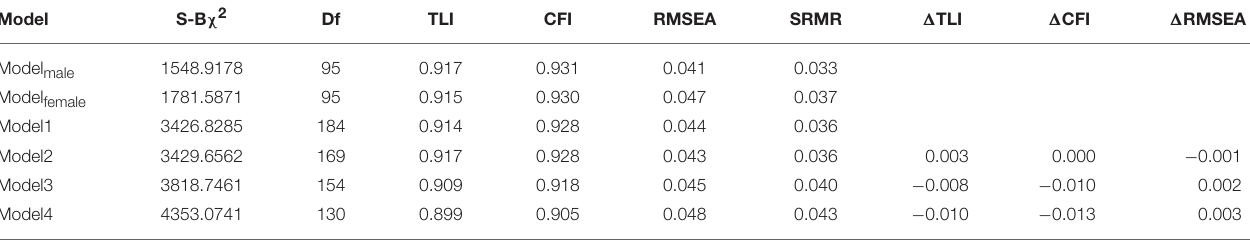
TABLE 3 | Measurement invariance of the neuroticism subscale across gender in the undergraduate sample. Model